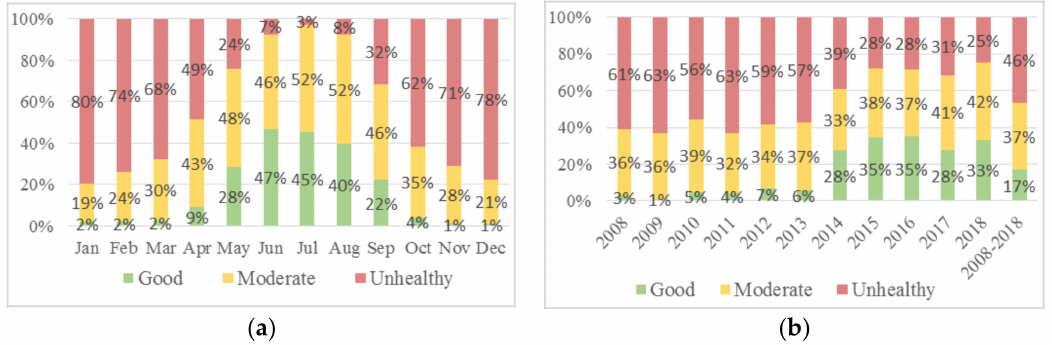
Figure 7. Composition of AQI classes in Fengshan: ( a ) Month-based; ( b ) Year-based and